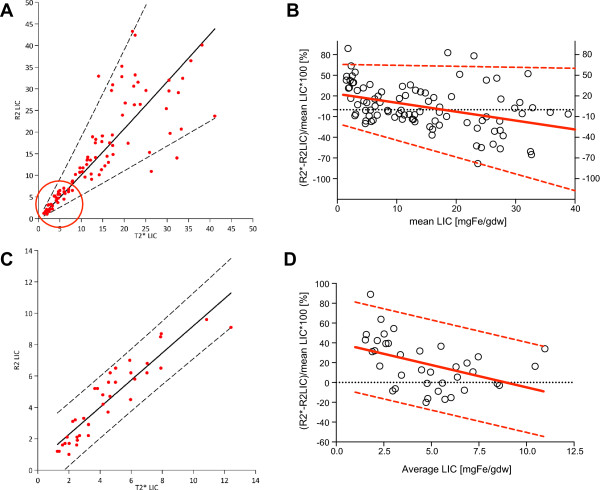
Relationship of new T2*-LIC to R2-LIC (Ferriscan) measurements. (A) R2-LIC plotted against T2*-LIC (derived from Equation 1) for comparison cohort; range with lowest scatter circled. Mixed model regression on whole range log-transformed data ln(R2-LIC) = 1.04×ln(T2*-LIC)-0.08, with slope and intercept 95% CI of 0.96 to 1.11 (p < 0.001) and -0.26 to 0.11 (p = ns), is shown here exponentiated to R2-LIC = 0.83×T2*-LIC1.04 with 95% CI 0.96 to 1.11 and 0.55 to 1.29, r squared = 0.65. (B) Whole range Bland-Altman plot of percentage difference vs mean LIC with non-uniform scatter with linear regression correction. Corrected bias is -1.29*(mean LIC)+23.03; absolute residuals R were related to LIC: R = 0.47*(mean LIC)+17.44, p = 0.01, therefore, accounting for growth in variance, 95% LoA were from -0.14*(mean LIC)+65.9 to -2.44*(mean LIC)-19.8 or changing from ±45 to ±90% across the whole range. (C) Mixed model linear regression of R2-LIC on T2*-LIC for R2-LIC range 0–10 mg/g dw: R2-LIC = 0.87 × R2*LIC-0.55, slope 95% CI 0.74 to 0.99 (p < 0.001), intercept -0.01 to 1.19 (p = 0.089); r squared = 0.86. Insignificant intercept can be abandoned to give a proportionality with a slope of 0.96, 95% CI 0.89-1.02, p < 0.001, which being indistinguishable from 1, follows the line of identity. (D) Bland-Altman plot of the mean of the two methods (x-axis) plotted against their percentage difference (y-axis) for the range marked by circle in 3A, which for R2-LIC values <10 mg/g dw (here in 37 scans on 26 patients) shows non-uniform scatter corrected by linear regression. Corrected bias is -4.51*(mean LIC)+40.23, p = 0.007, SD of residuals 23.22%. Absolute residuals did not relate to LIC (p = 0.99), therefore 95%LoA were bias ± 1.96*23.22% or ±45.51%.